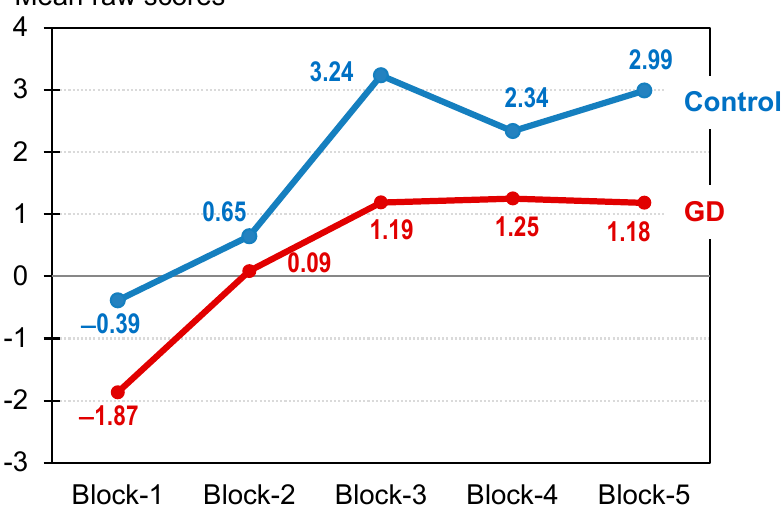
Figure 2. Performance-learning curve in the Iowa Gambling Test task. Note. GD: gambling disorder ( n = 297). Control ( n = 41).